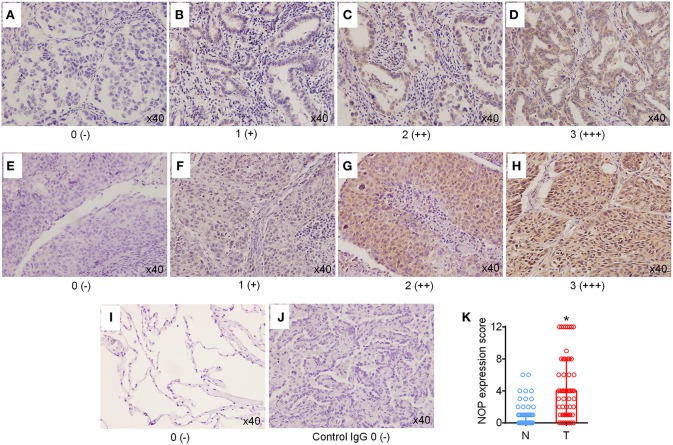
High expression levels of NOP in NSCLC tissues. (A–D) Representative immunohistochemical (IHC) staining of NOP in lung adenocarcinoma. Scores 0, 1, 2, and 3 represent negative (–), weak positive (+), moderate positive (++), and strong positive (+++) expression, respectively. (E–H) Typical IHC staining of NOP in lung squamous cell carcinoma. Scores 0, 1, 2, and 3 represent negative (–), weak positive (+), moderate positive (++), and strong positive (+++) expression, respectively. (I) Representative NOP staining in para-cancer normal lung tissue. (J) NOP staining with rabbit IgG Isotype control antibody. No non-specific background signal was detected. (K) Comparison of NOP expression score between tumor tissue (T) and the corresponding adjacent normal lung tissues (N). *P < 0.05 from Mann-Whitney test.